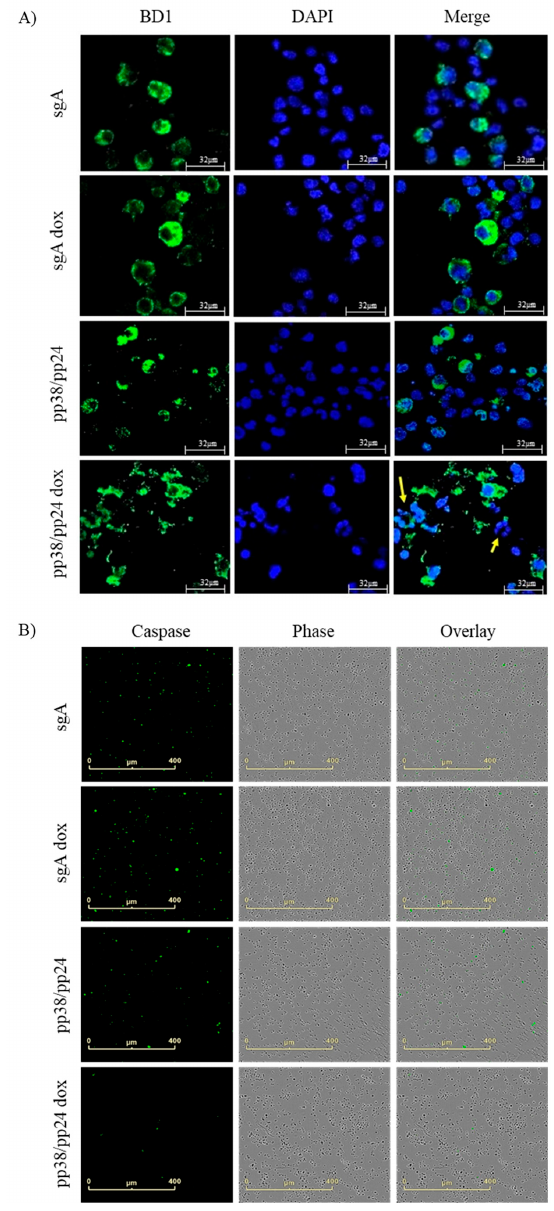
Figure 5. pp38/pp24 overexpression induces increased cytopathic effect but inhibits apoptosis. ( A ) Cytopathic effect in pp38/pp24-overexpressed cells was analysed via IFA. C4 cells transfected with sgA or pp38/pp24-specific gRNAs with and without doxycycline treatment were fixed 24 h pt. The cells were labelled with anti-pp38 mAb BD1 followed by goat anti-mouse AF488 (green) and nuclei were stained with DAPI (blue). The images were captured using confocal image analyser at 10 × magnification. sgA, sgA dox and pp38/pp24 (no dox) represent the control cells showing intact nuclei whereas pp38/pp24-overexpressed (pp38/pp24 dox) cells showed necrotic nuclei (yellow arrow). The scale bar, 32 µ m. ( B ) Apoptosis assay quantified using Incucyte ® Caspase-3/7 Green Reagent. C4 cells transfected with sgA or pp38/pp24-specific gRNAs with or without doxycycline were treated with IncuCyte ® Caspase-3/7 Green Reagent. The green fluorescence indicates the apoptotic cells and cells were analysed with the IncuCyte S3 live-cell imaging system. The control cells (sgA, sgA dox and pp38/pp24) showed many green fluorescence cells whereas the pp38/pp24 dox showed few green fluorescence cells. The scale bar, 400 µ